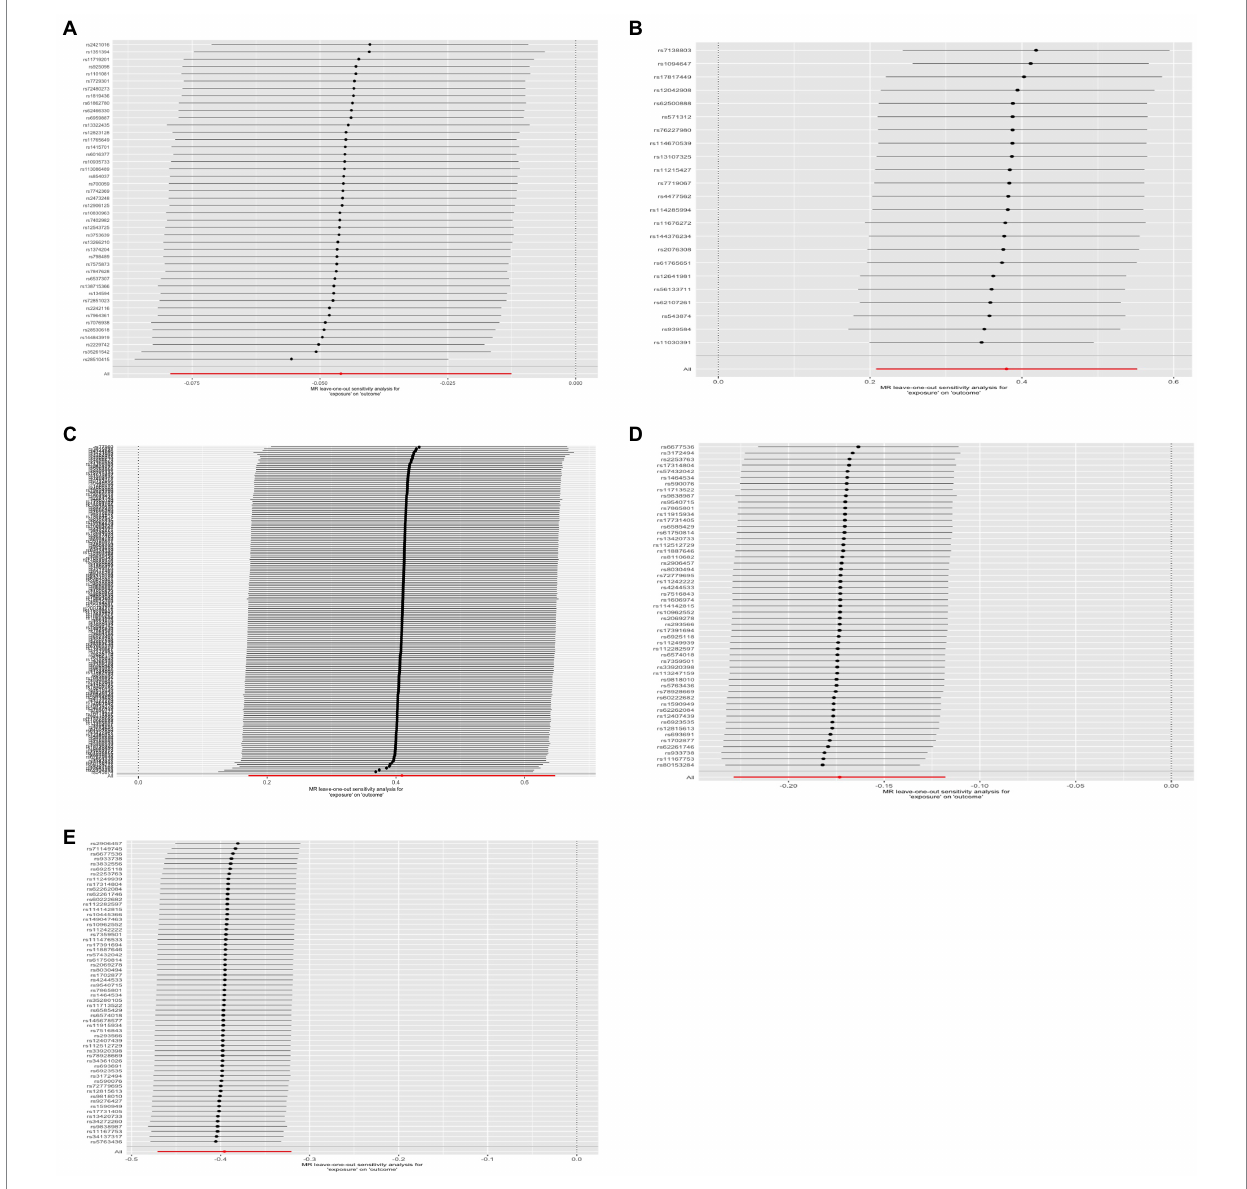
FIGURE 5 Leave-one-out analysis plot. The estimation effects are reported per SD increase in the exposure, and error bars represent 95% CI. (A) Lower birth weight (BW)-Alzheimer’s disease (AD); (B) childhood body mass index (BMI)-attention-deficit hyperactivity disorder (ADHD); (C) early life body size- ADHD; (D) age at first birth (AFB)-major depressive disorder (MDD); (E) AFB-ADHD; the solid dot means the causal effects of exposure on outcomes with four methods [MR-Egger (MRE); weighted median (WM); weighted mode (Wm); inverse-variance weighting (IVW); MR-Egger and Mendelian Randomization Pleiotropy RESidual Sum and Outlier (MR-PRESSO)]. The results of the binary outcomes are shown by OR [95%CI]. Numbers in bold mean P- values <5.00E-02, and italic and bold font means P- values